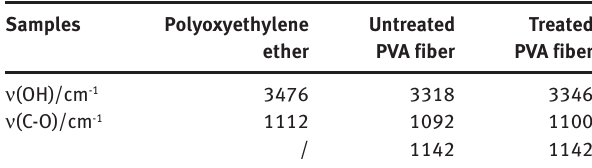
, δ , ν of the modifier and PVA OH OH C-0